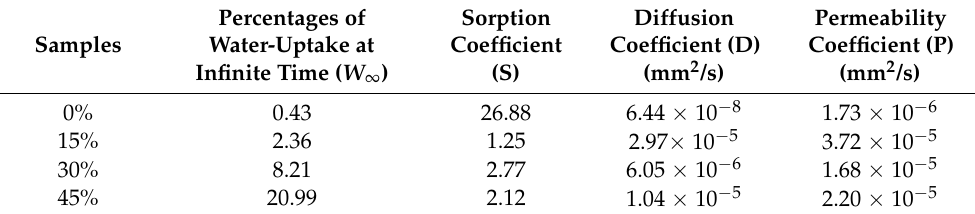
Table 2. Diffusion, sorption, and permeability study of composites.